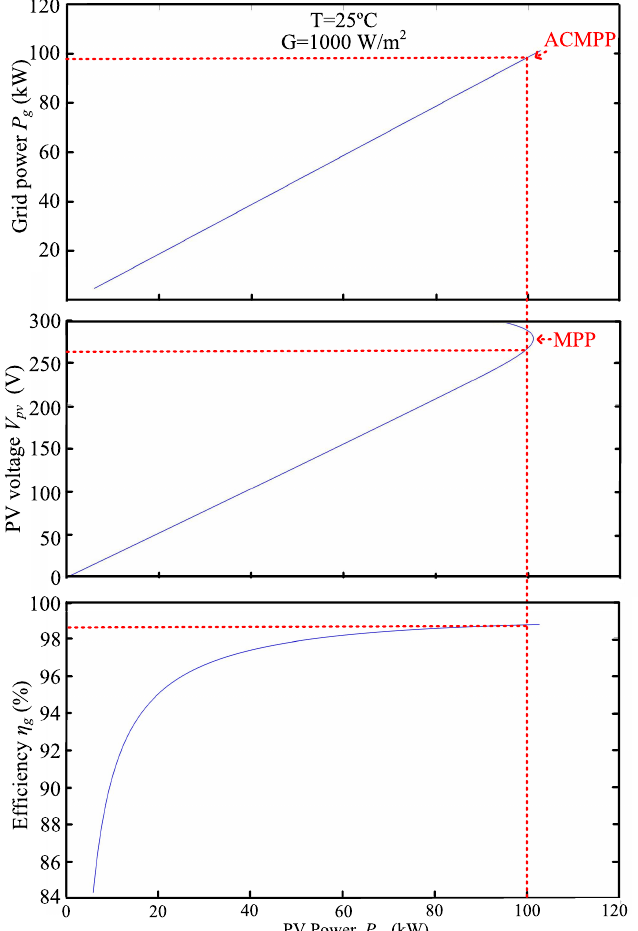
Figure 16. P g − P pv , P-V and efficiency curves of PV system operating on left side of